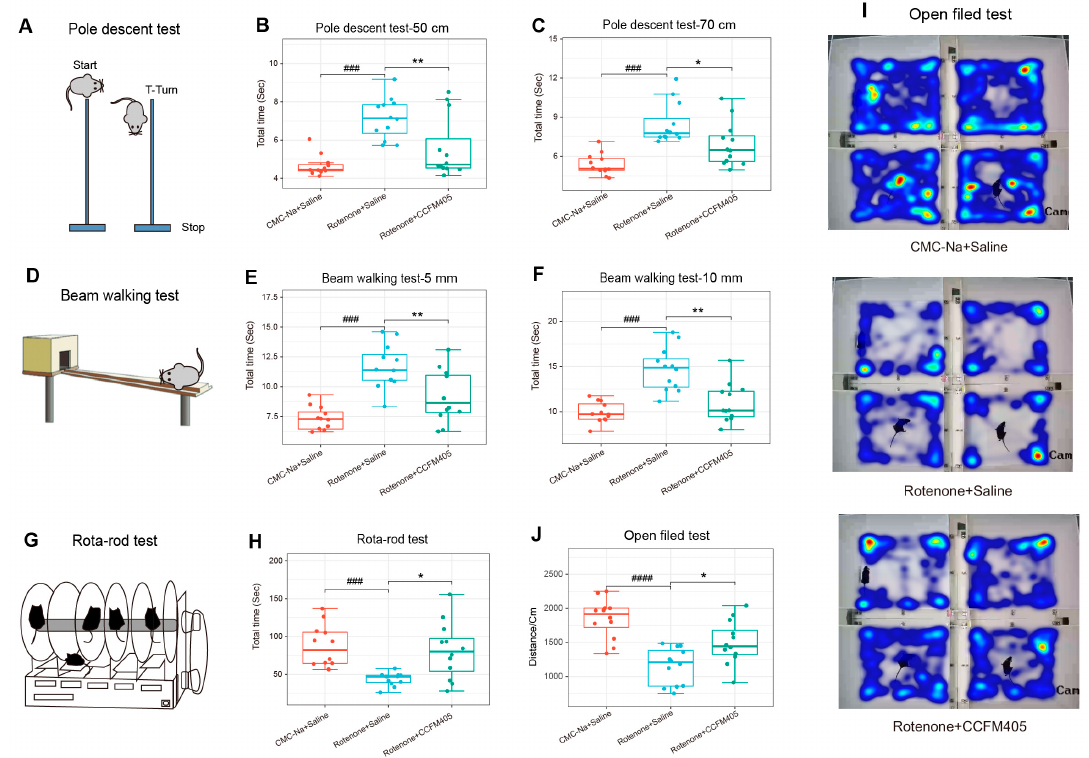
Figure 2. Effect of L. plantarum CCFM405 on movement performance in rotenone-challenged PD mice. ( A ) Cartoon diagram of the Pole descent test; ( B ) Pole descent test (50 cm pole); ( C ) Pole de- scent test (70 cm pole); ( D ) cartoon diagram of the Balance walking test; ( E ) Balance walking test (5 mm wide balance beam); ( F ) Balance walking test (10 mm wide balance beam); ( G ) cartoon diagram of the Rotating rod test; ( H ) Rotating rod test (30 rpm); ( I ) representative heat maps of tracking movement trajectories of mice in each group; ( J ) Open Field test. n = 11–12/group. Data are means with SEM. ### p < 0.001, #### p < 0.0001 signs Rotenone+Saline group vs. CMC-Na+Saline group; * p < 0.05, ** p < 0.01 signs Rotenone+CCFM405 group vs. Rotenone+Saline grup.